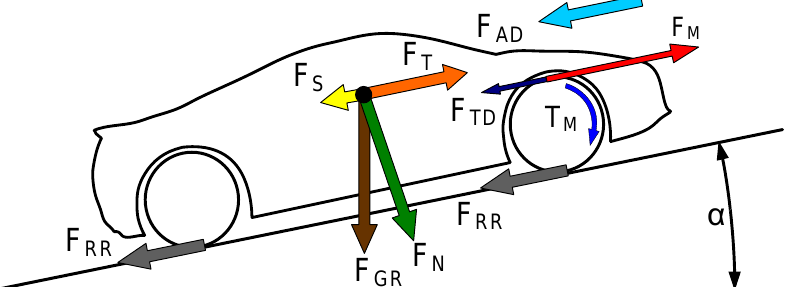
Figure 3. Forces acting on a moving vehicle: F AD , total aerodynamic drag force; F T , traction force acting on the vehicle; F S , total sliding force; F TD , the force acting on the moving vehicle as a result of friction in the transmission system; F RR , rolling resistance forces; F M , traction force; F GR , weight of the vehicle; F N , normal force of the vehicle; T M , traction torque; α, road inclination.